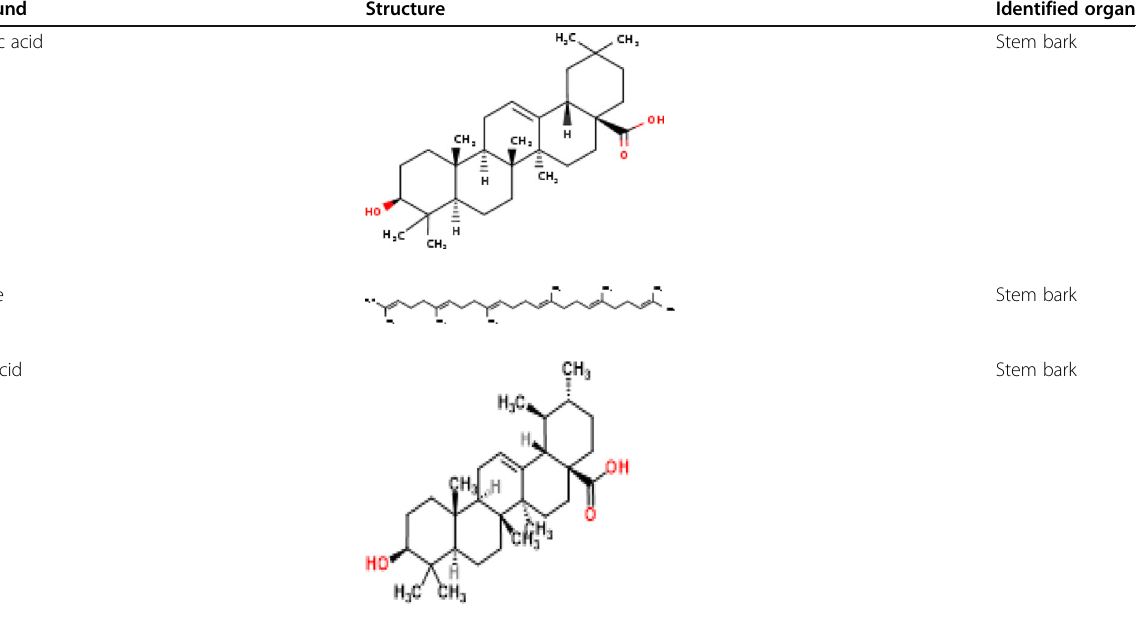
Table 3 Triterpenoids from morphological organs of H. umbellate